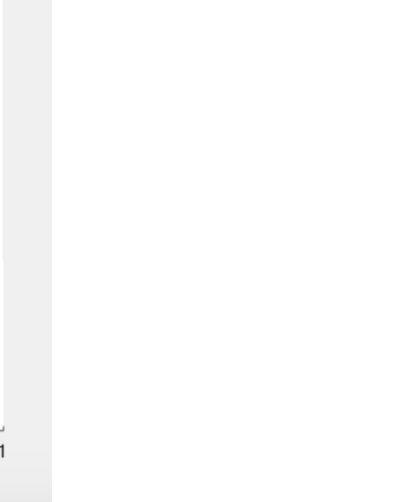
Figure 6. ROCs of the testing set. Blue: Neutral. Green: Angry. Dark Yellow: Happy. Purple: Sad.